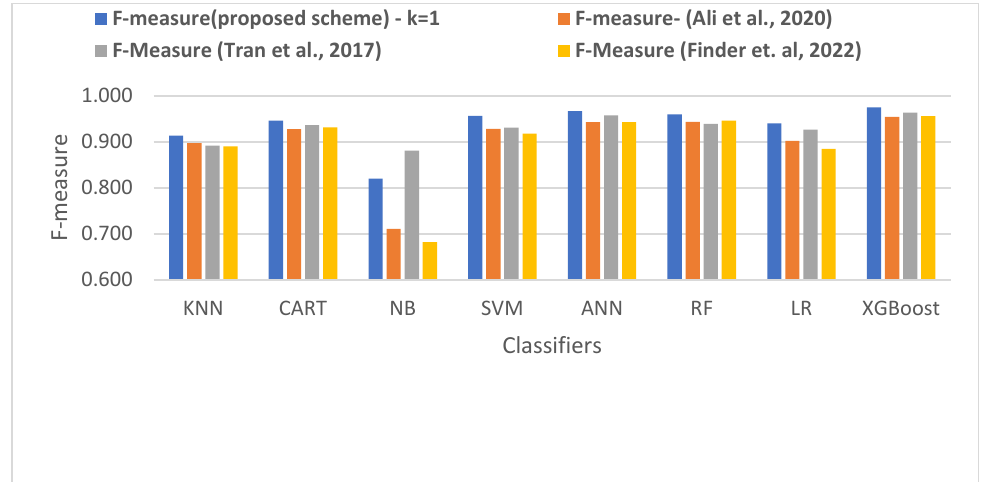
Figure 7. The comparison of the Detection Accuracy between the proposed DIEBD-based scheme and the related work-based schemes.